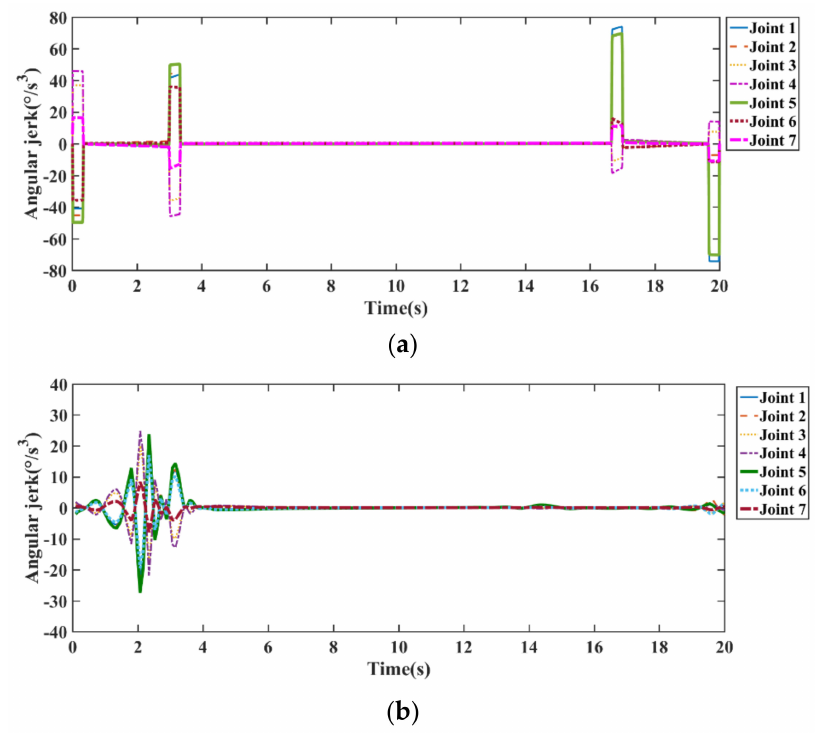
Figure 22. Joint angular jerk of trajectories. ( a ) Without optimization, ( b ) With